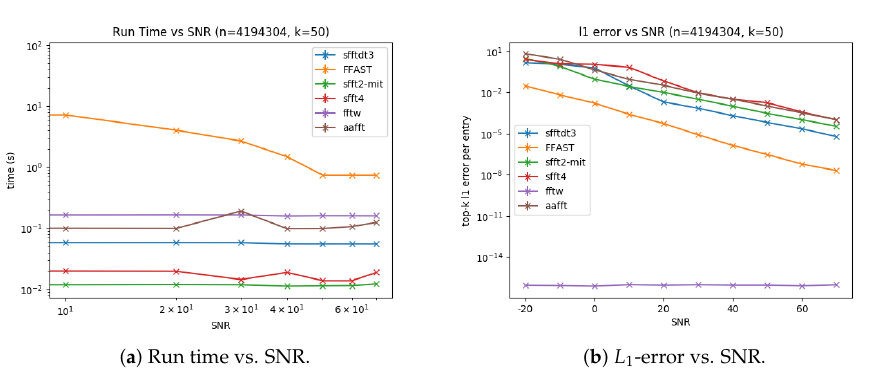
Figure 12. Run time and L 1 -error of two typical algorithms using the aliasing filter and four other algorithms, including the sFFT-DT3.0, R-FFAST, sFFT2.0, sFFT4.0, fftw, and AAFFT0.9 algorithms in the general sparse case vs.